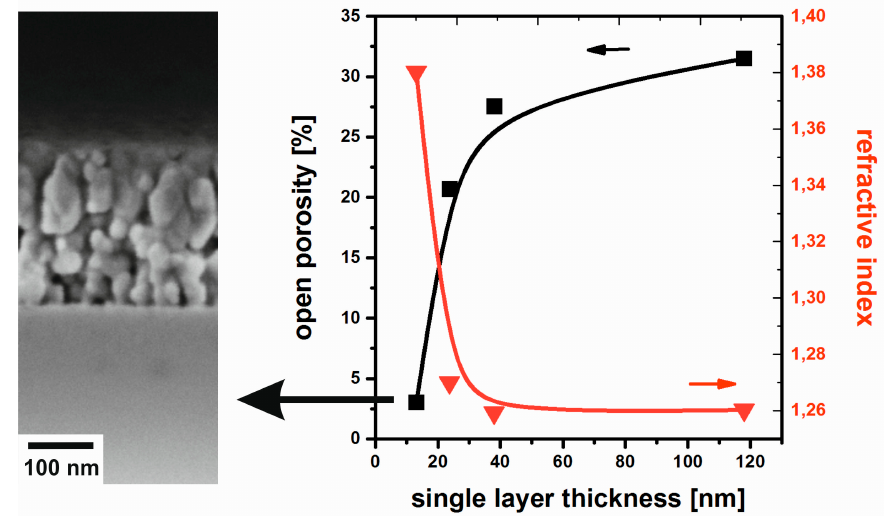
Figure 9. Open porosity and refractive index of MgF 2 films with different single layer thickness. The inset shows the SEM image of a 15-fold coating. Based on [48].